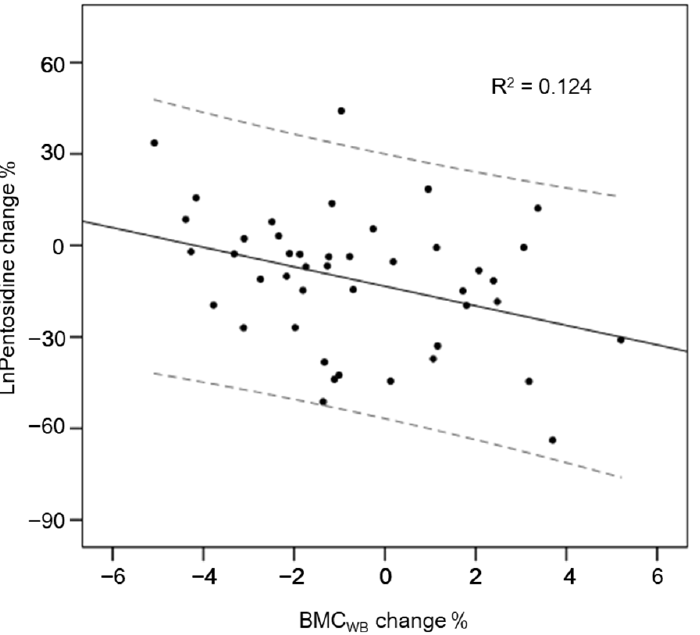
Figure 2. Correlation between pentosidine change and BMC WB change of pre-and post-intervention. Note: BMC WB , bone mineral content of the whole body.